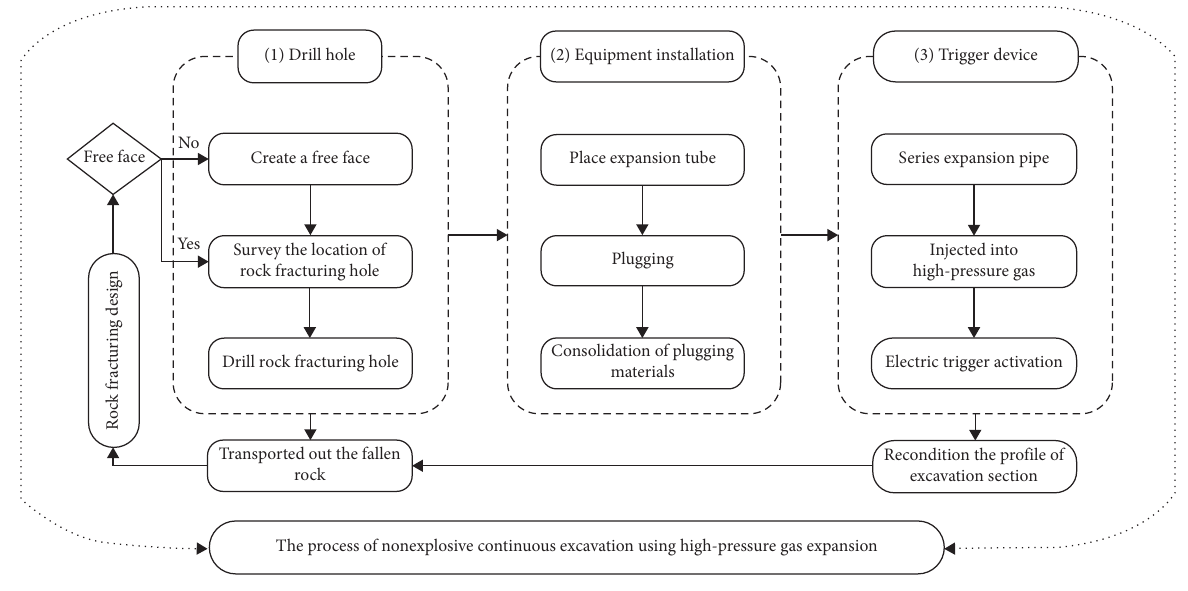
Figure 7: Rock fracturing